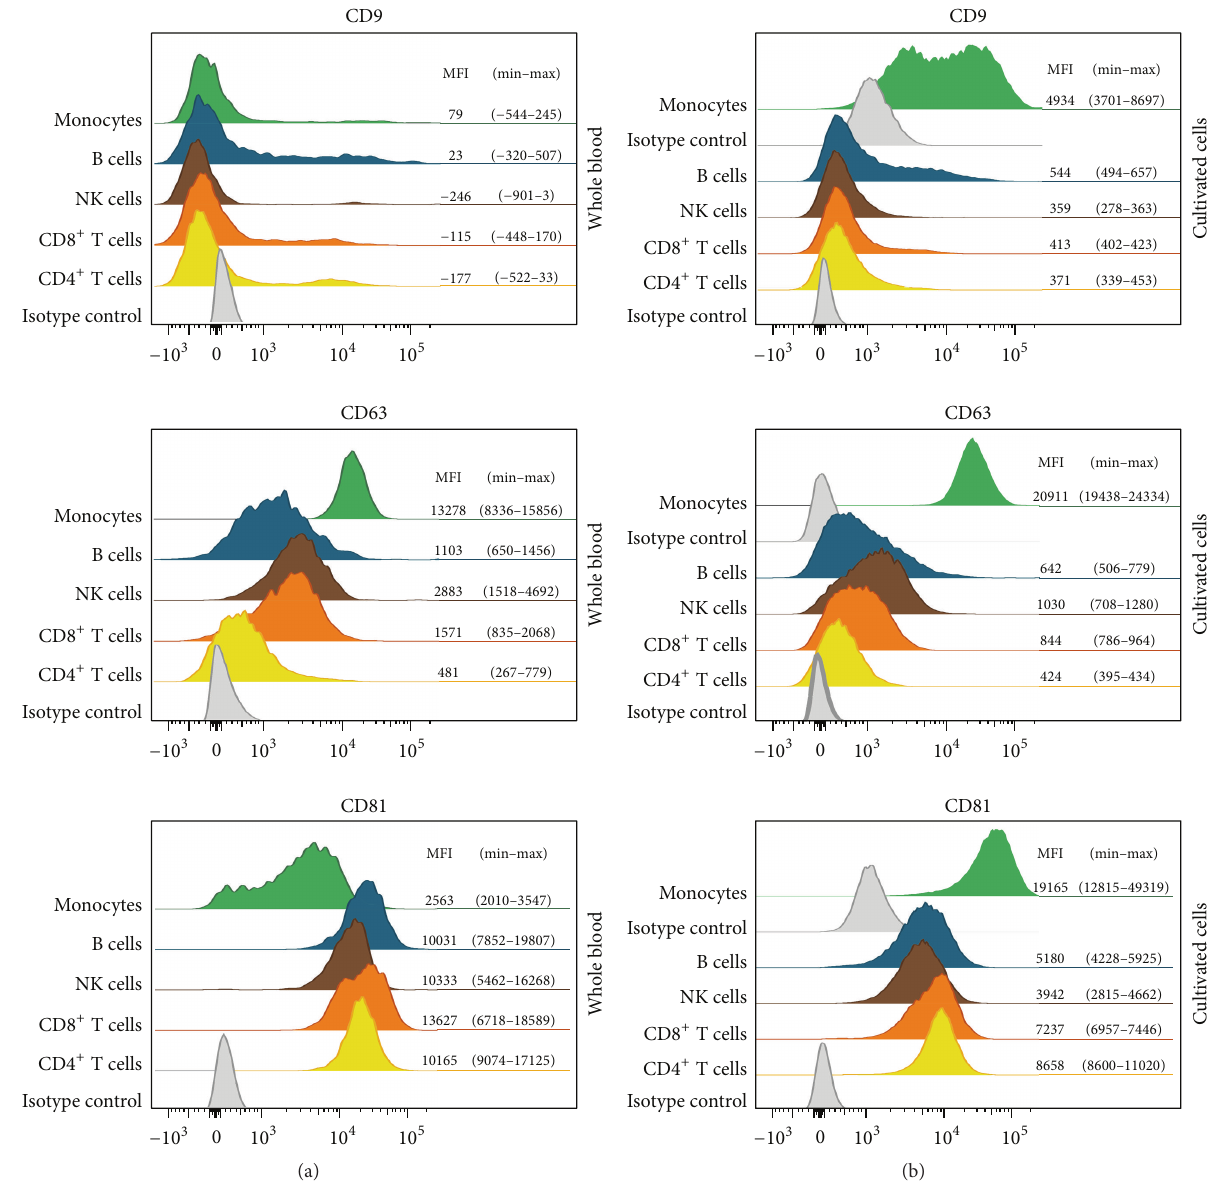
Figure 3: Cellular expression of CD9, CD63, and CD81 on five leukocyte subpopulations. The cellular expression pattern of CD9, CD63, and CD81 was investigated for leukocytes present in freshly drawn whole blood (a) as well as for isolated subpopulations of leukocytes following two days of culture (b). For each of the subpopulations, the expression pattern was determined by flow cytometry. The expression from two representative donors is illustrated in histograms. Isotype controls were included for every leukocyte subpopulation and when the obtained signals were similar, only one isotype control is depicted. Regarding the cultivated cells, a representative lymphocyte isotype control is shown. Due to differences in the level of the isotype control between the lymphocytes and the monocytes, the monocyte isotype control is also shown. The interdonor variation in the expression levels of the different markers is displayed next to each histogram. Data are presented as median fluorescence intensities (MFI) with min and max indicated in parenthesis from the ten (whole blood) or three donors (cultivated cells),